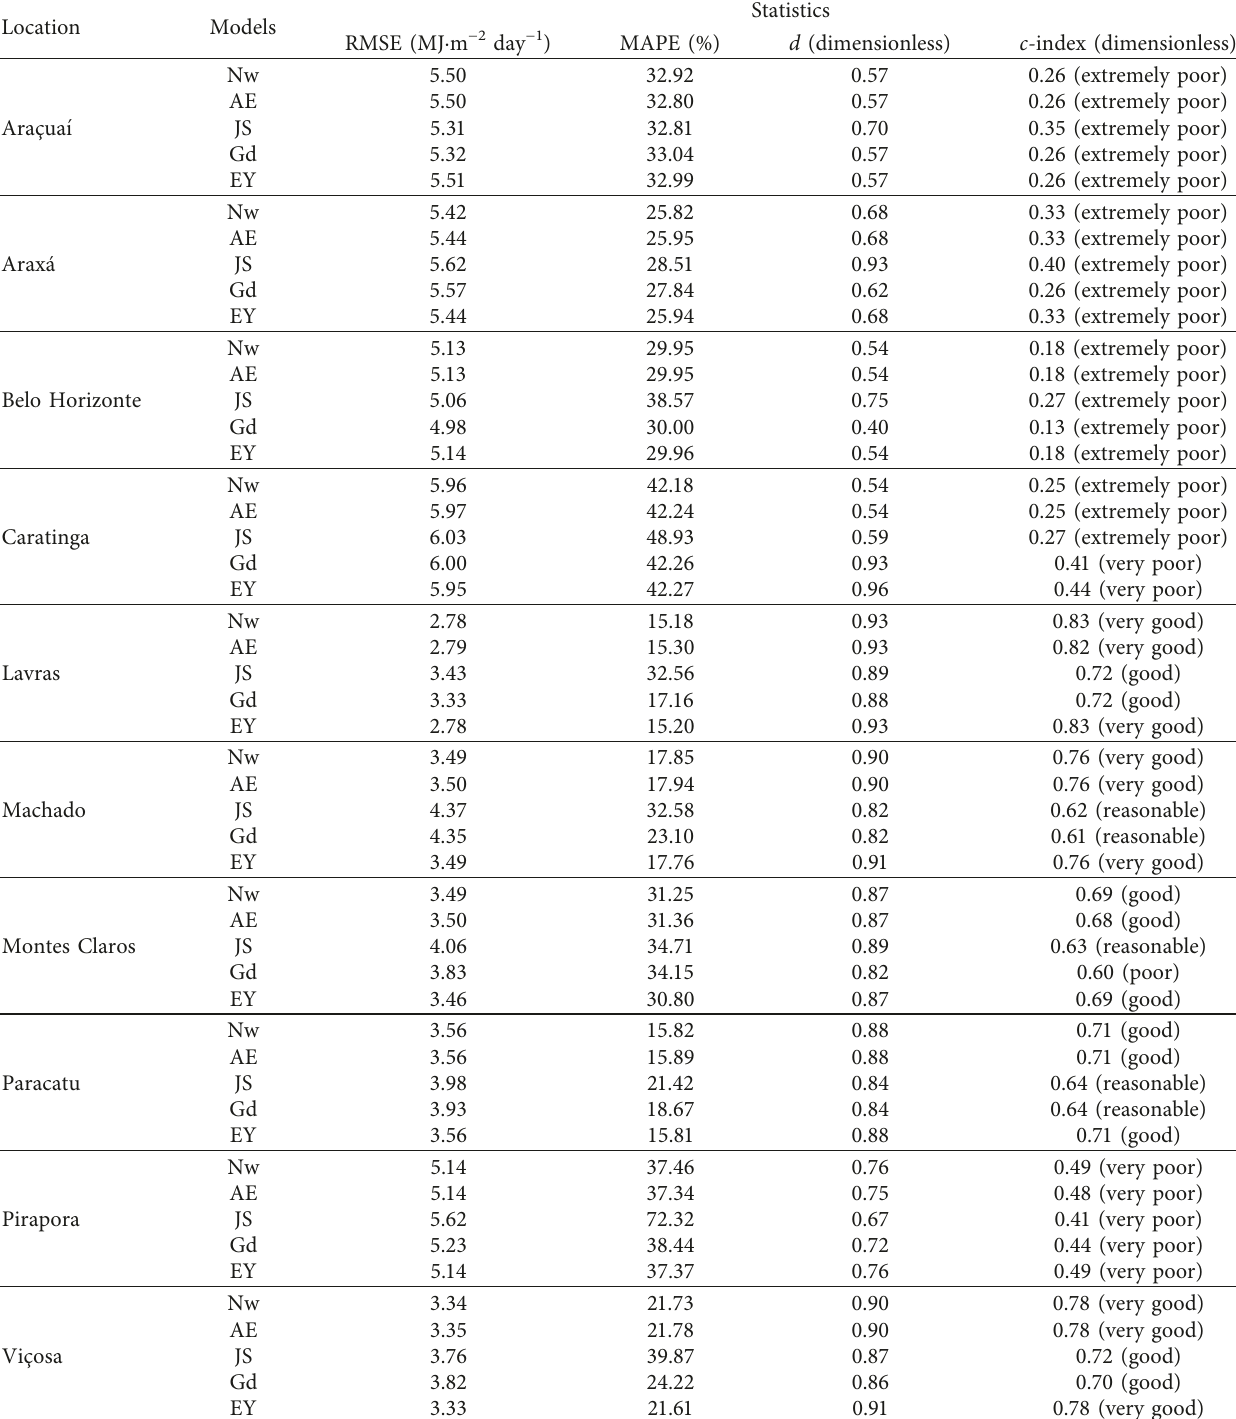
Table 3: Validation performance carried out for the models that presented the best fits for global solar radiation estimations in Minas Gerais